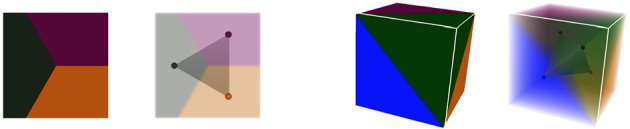
Duality in different dimensions: in 2D, three regions of adjacent geometry create a triangular simplex of adjacency in the dual domain, as in 3D the dual of 4 adjacent regions forms a tetrahedral simplex.